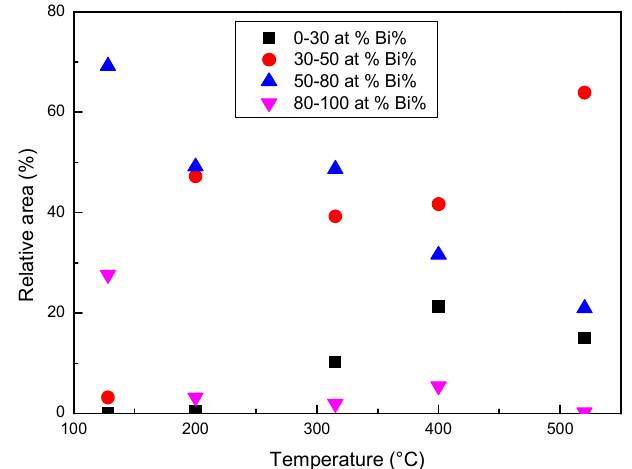
Figure 12. The relative area of the pixels with Bi in four different ranges (at %) determined from the images in Figure 10.